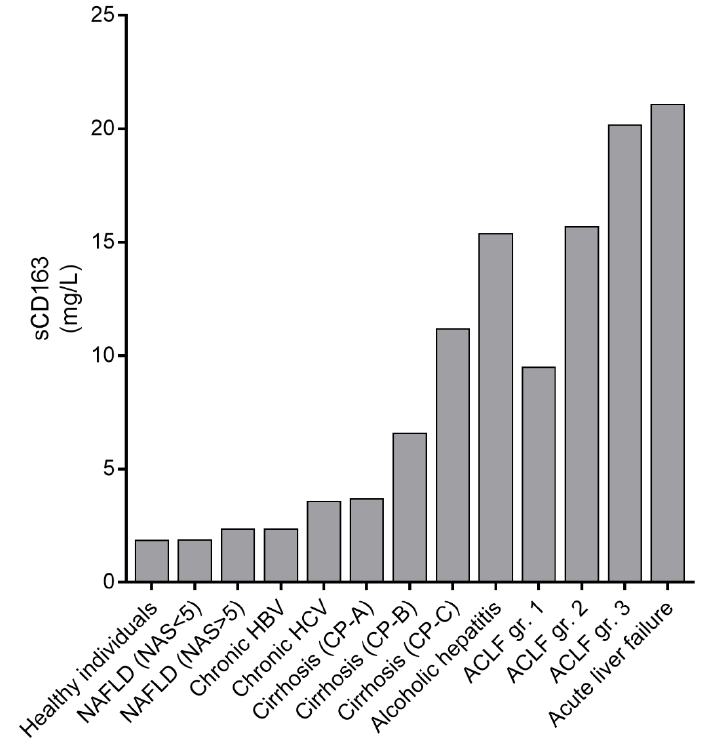
Figure 4. Median concentrations of sCD163 from selected studies covering healthy individuals and patients with liver diseases of di ff erent etiology and increasing liver disease severity [6,28,33–35,83,93]. NAFLD, non-alcoholic fatty liver disease; NAS, NAFLD activity score; HBV, hepatitis B virus; HCV, hepatitis C virus; CPA, Child-Pugh-score A; CPB, Child-Pugh-score B; CPC, Child-Pugh-score C; ACLF, Acute-on-Chronic Liver Failure; gr.,